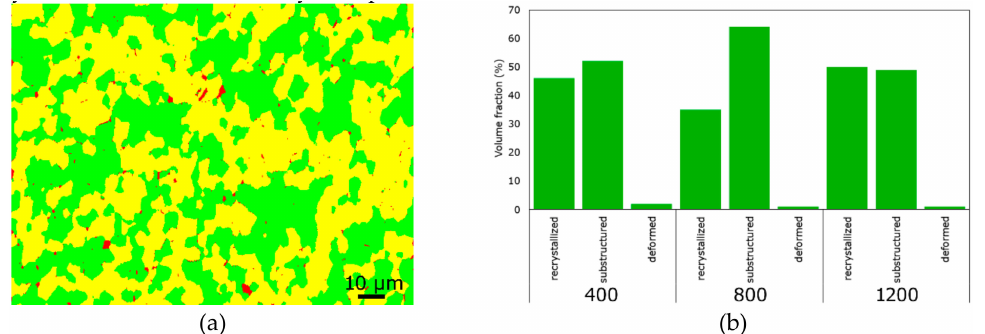
Figure 4. Recrystallized, substructured, and deformed fractions: example of analyses evaluation for RS + 400 RMP FSP sample ( a ); summary for RS + FSP-processed samples ( b